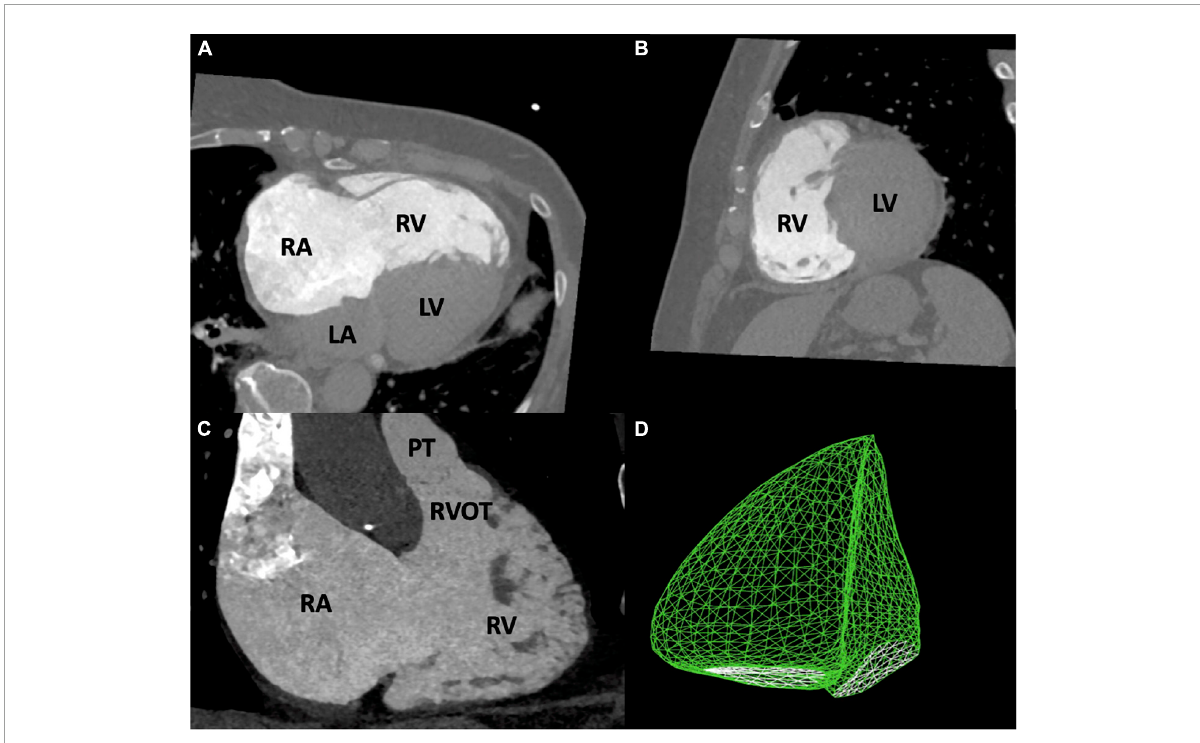
FIGURE1 Anatomy of the right ventricle. This figure shows images of the right heart derived from multidetector computed tomography (A–C) and three-dimensional echocardiography (D) . The RV is crescent shaped in an axial (A,C) and triangular in a lateral view (B) . LA, left atrium; LV, left ventricle; PT, pulmonary trunk; RA, right atrium; RV, right ventricle; RVOT, right ventricular outflow